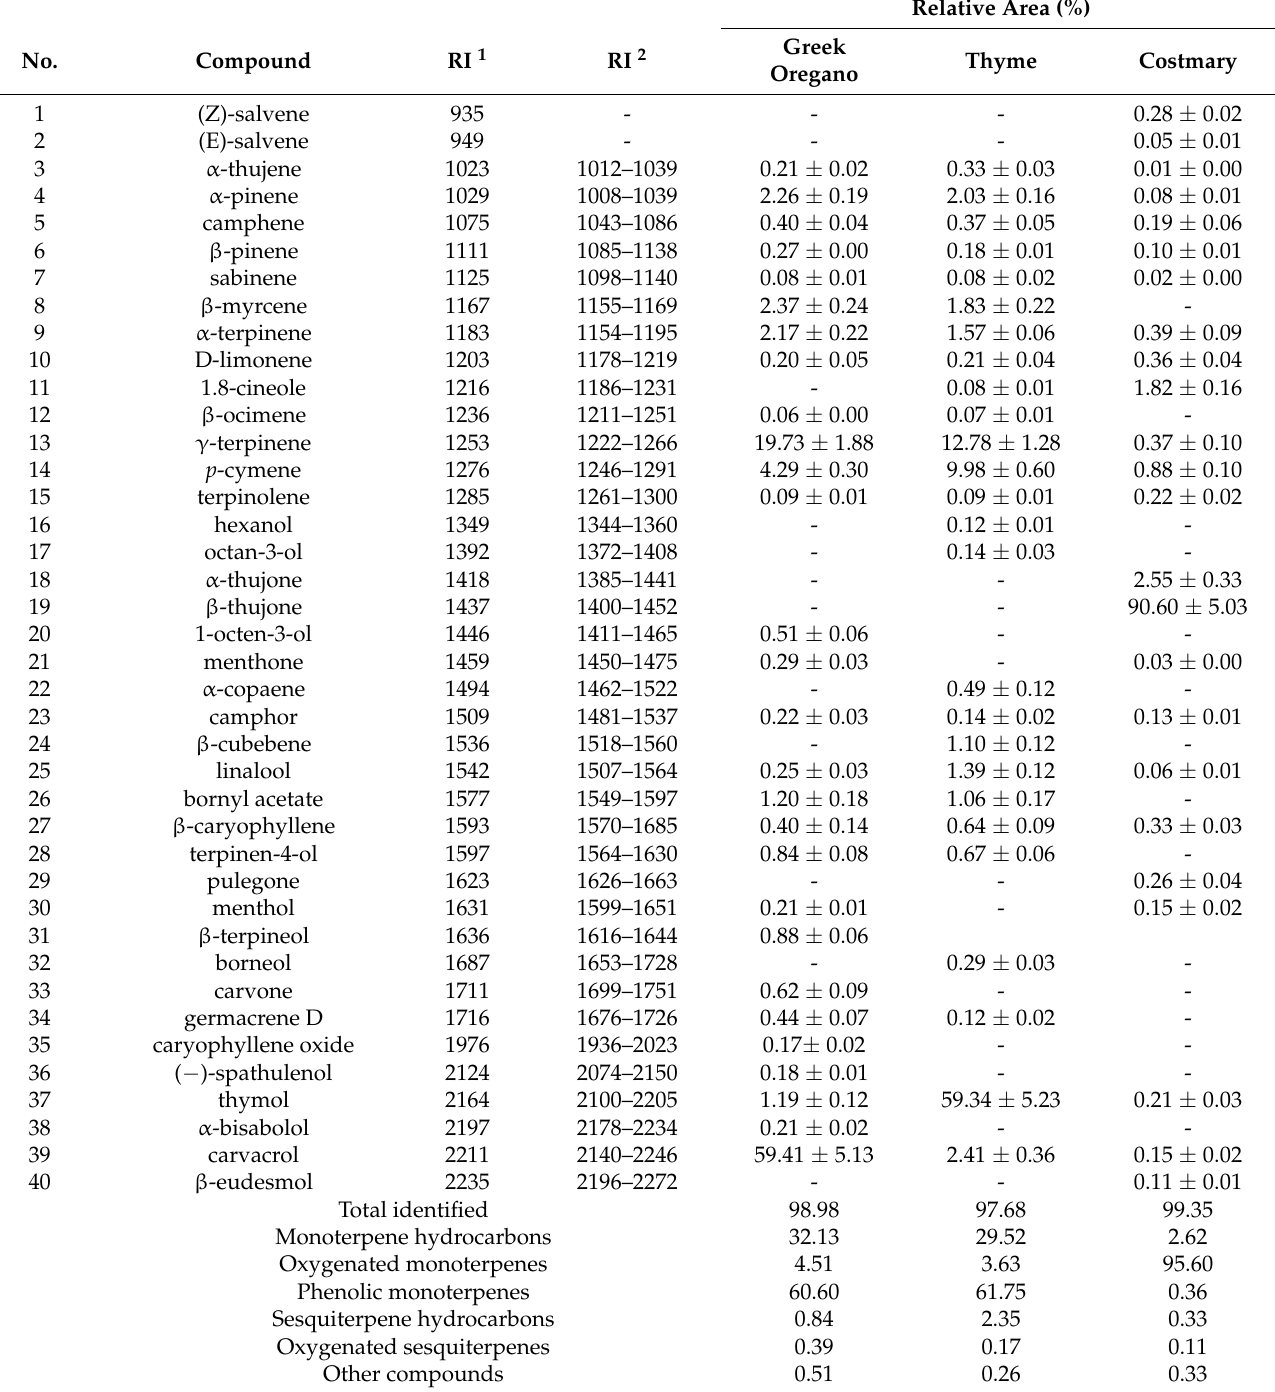
Table 1. The composition of the EO